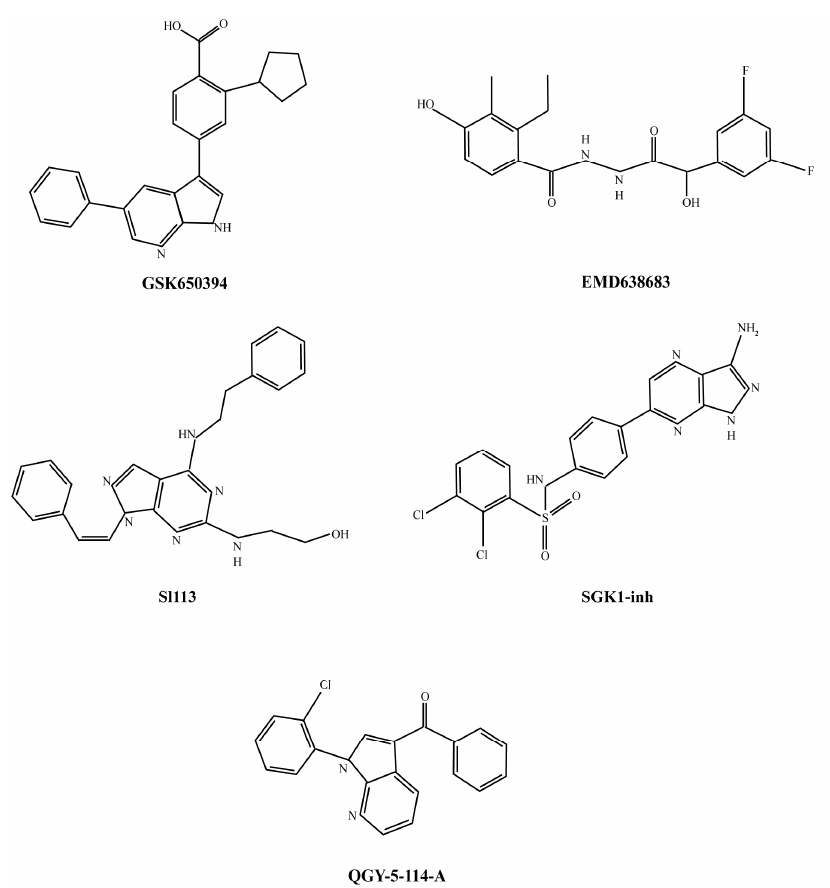
Figure 2. Chemical structure of small molecules capable of inhibiting SGK1.